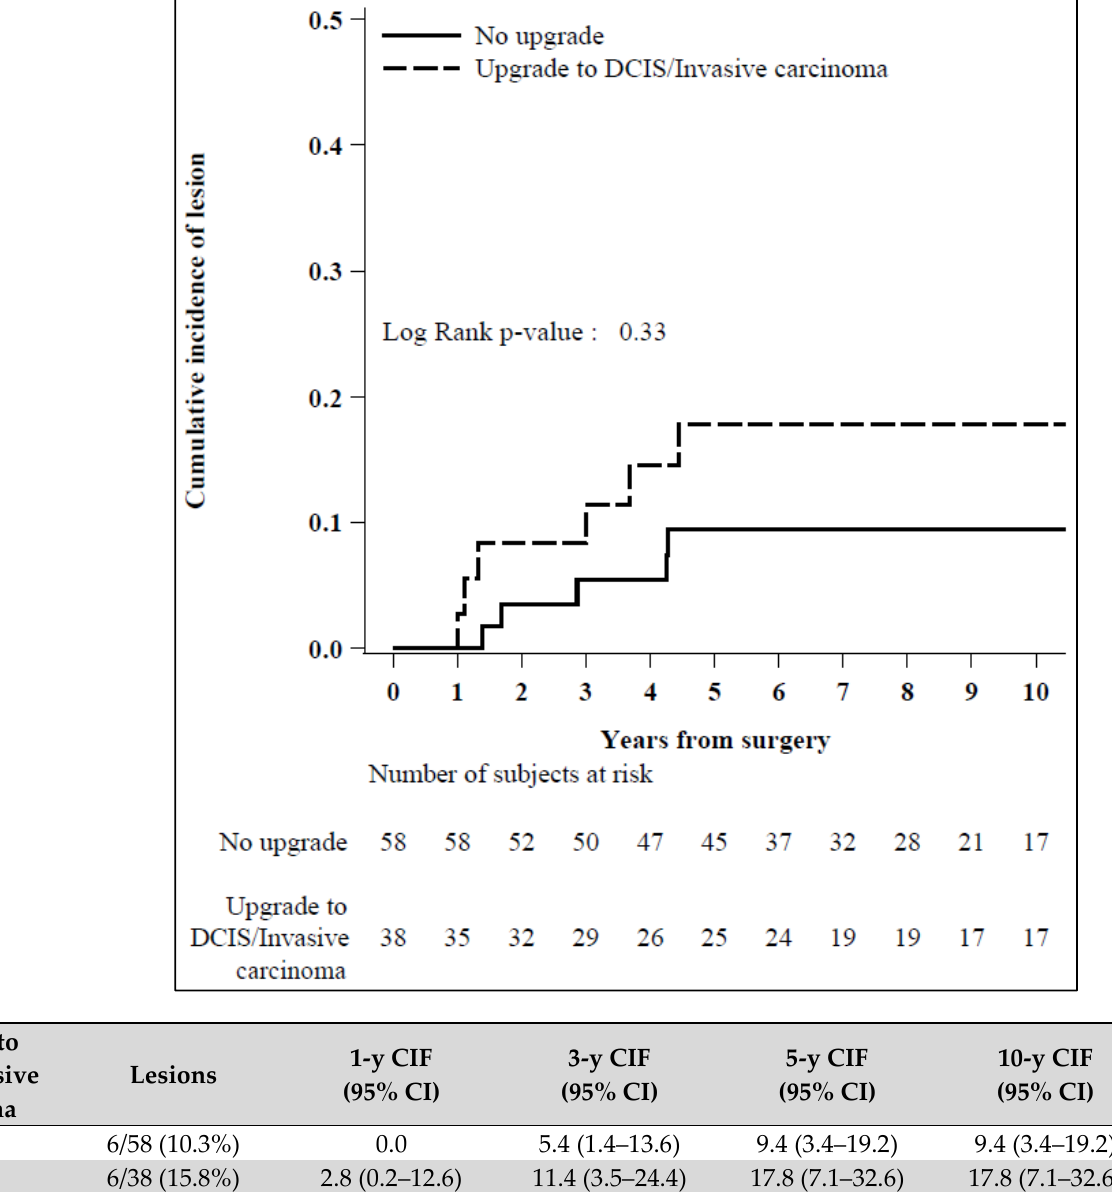
Table 5. Association between patients’ characteristics and incidence of lesion (univariate analysis) (N = 96).